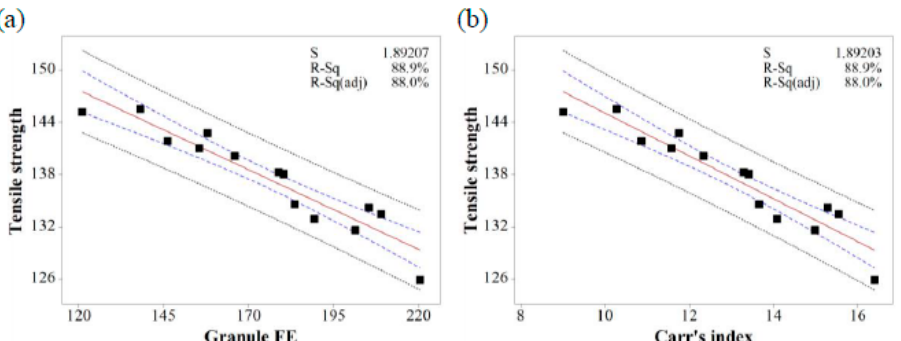
Figure 12. The fitted line plots of ( a ) tensile strength versus granule FE and ( b ) tensile strength versus Carr’s index. The black dots, red line, blue dotted line, and black dotted line represent the experimental results, best fitted regression, 95% confidence intervals, and 95% prediction intervals, respectively.